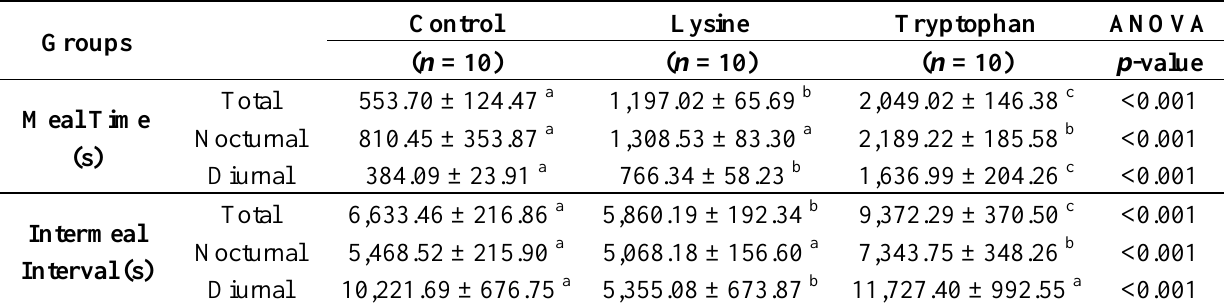
with 5% lysine or